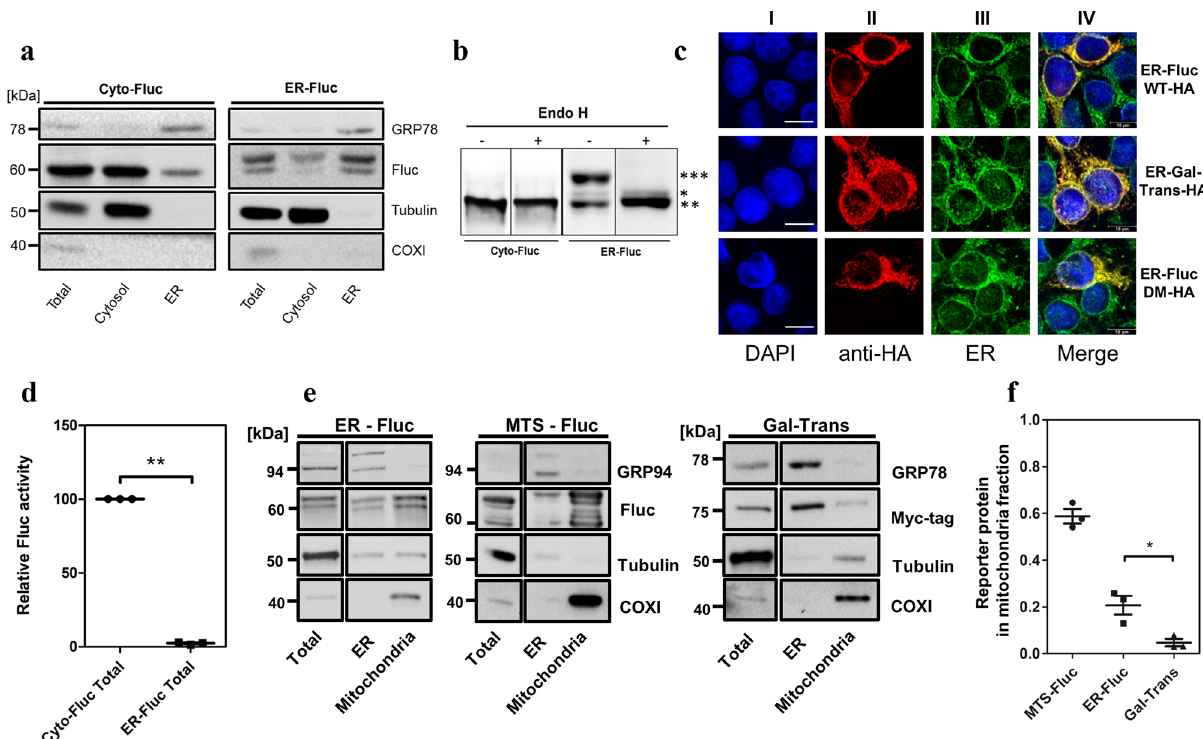
Fig. 1 Subcellular localization of ER-Fluc. a Representative Western blot analysis of cellular fractions isolated from HEK293 cells expressing cyto-Fluc and ER-Fluc; marker proteins to follow fractionation were: GRP78 (ER), COX1 (mitochondria), tubulin (cytosol). b Representative Western blot of cyto-Fluc and ER-Fluc samples treated with endoglycosidase H; three different bands are identi fi ed for ER-Fluc: *** ER-localized cleaved, glycosylated Fluc (upper band), ** ER-localized cleaved, non-glycosylated Fluc (lower band), * not cleaved cytosolic-localized Fluc (middle band). As per construction of ER-Fluc, the cleaved and non-glycosylated ER-Fluc has the same molecular weight as cyto-Fluc. c Confocal microscopy to demonstrate ER localization of HA-tagged